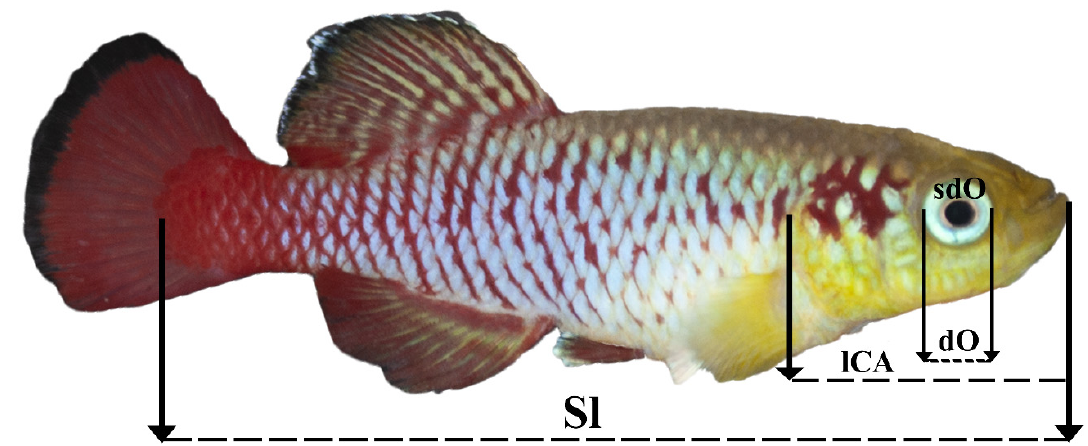
Figure 1. Morphological characteristics measured in this work. Sl—standard length; lCA—head length; dO—eye diameter; sdO—eye area.